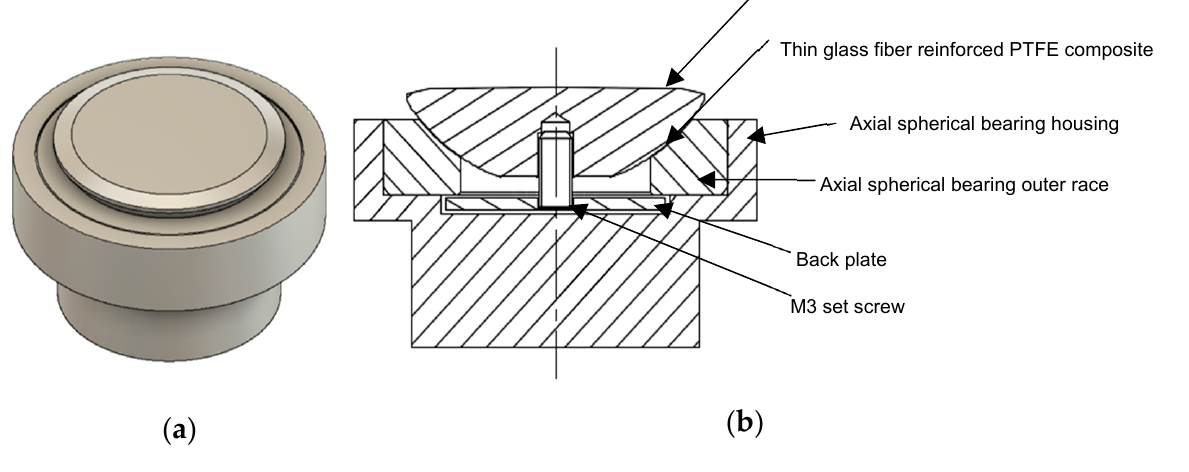
Figure 6. Self-alignment attachment for the compression tests: ( a ) isometric view, ( b ) and section front view.